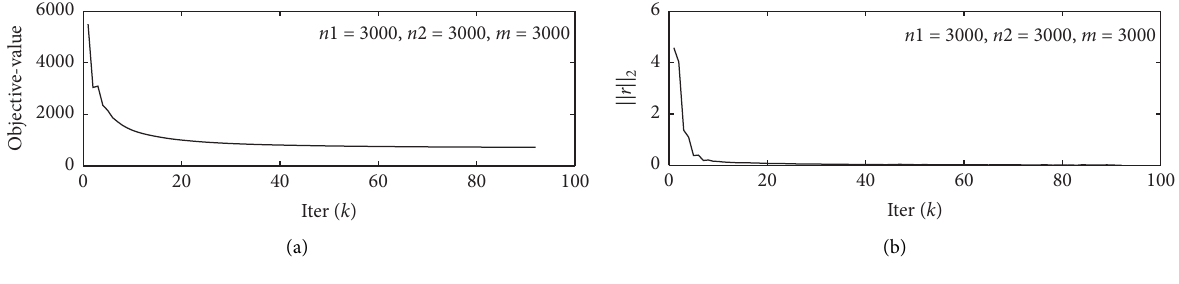
Figure 2: n 1 � 3000, n 2 � 300, and m � 3000.